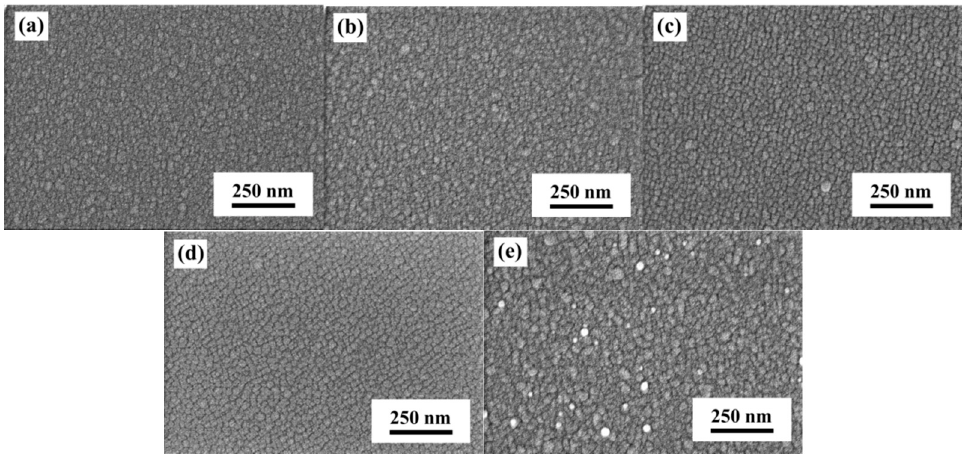
Figure 1. Surface SEM observations of the α -IGZO/Ag/ α -IGZO triple-layer structures as a function of thickness of Ag film. ( a ) 10; ( b ) 11.5; ( c ) 13; ( d ) 14.5; and ( e ) 16 nm, respectively.